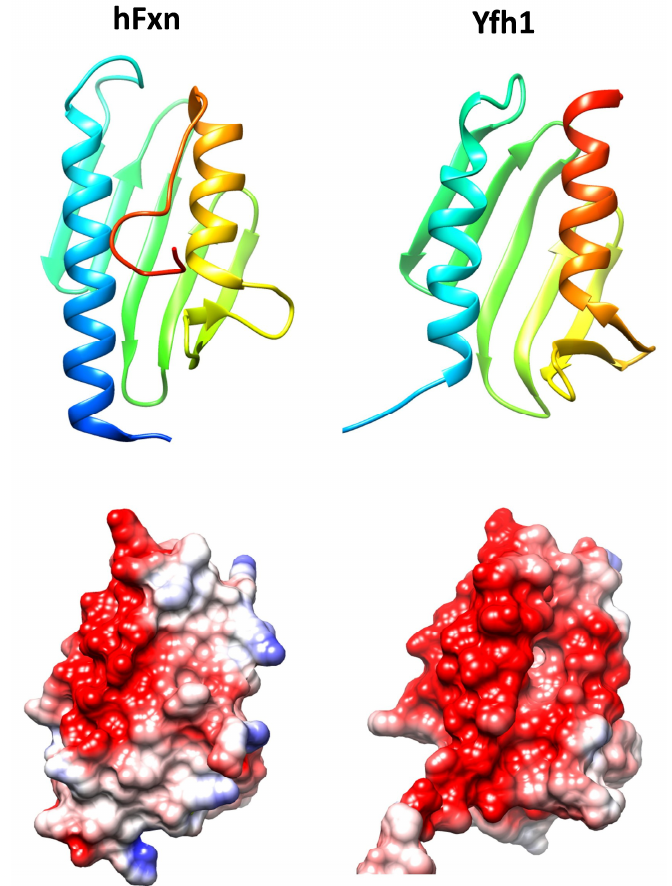
Figure 1. Structures of human frataxin (hFxn, pdb code 3s4m) and Yeast Frataxin Homologue 1 (Yfh1, pdb code 2fql). Top, ribbons representations showing the conserved alpha-beta-alpha structure. Structures are colored according to sequence, from dark blue (N-terminal) to red (C-terminal). In human frataxin the C-terminal region folds over the hydrophobic cavity formed between both alpha helices. Below, coulumbic surface coloring of the same structures. The red color indicates the presence of a marked acidic ridge, which may be involved in iron binding. Molecular graphics and analyses were performed with the UCSF Chimera package